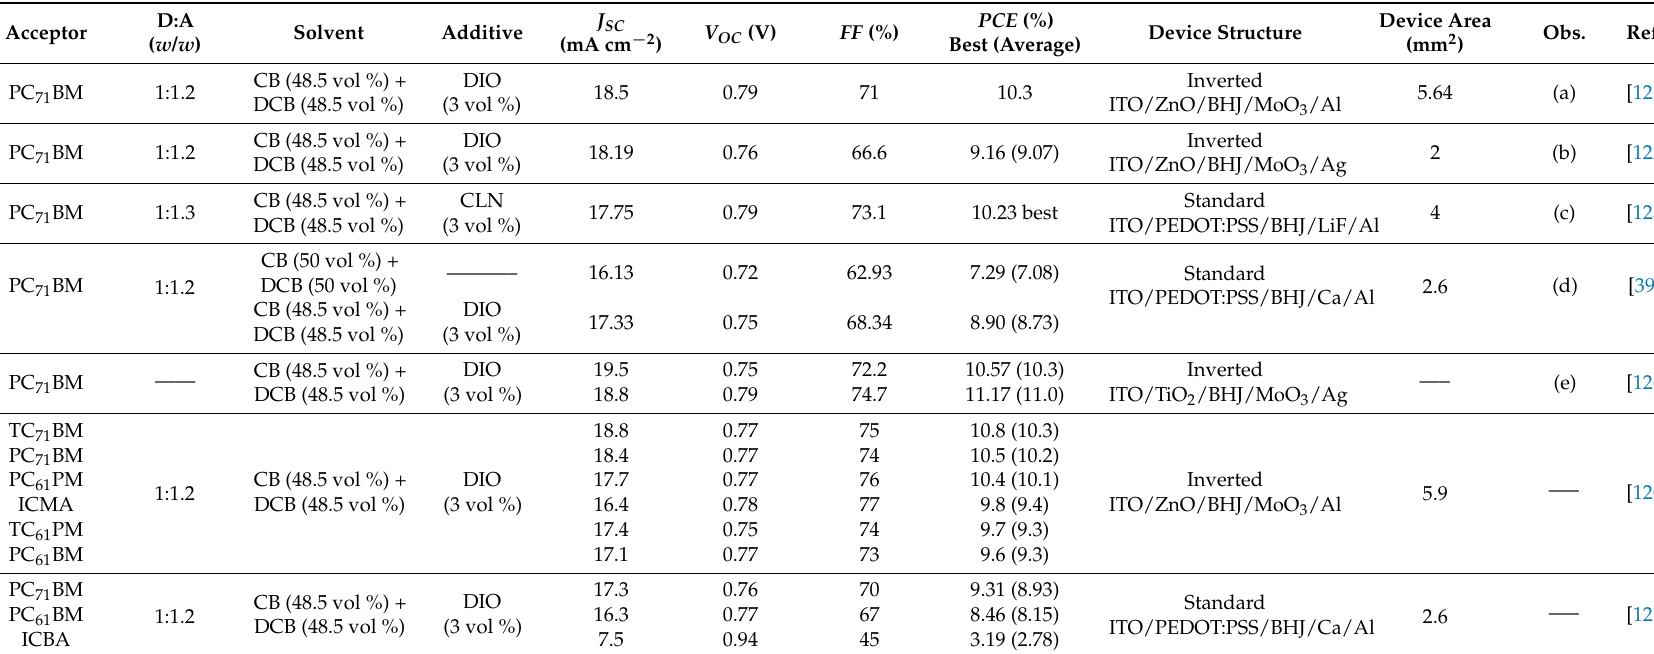
Table 3. Summary of the most relevant device figures of merit and efficiency results obtained with PffBT4T-2OD:fullerene